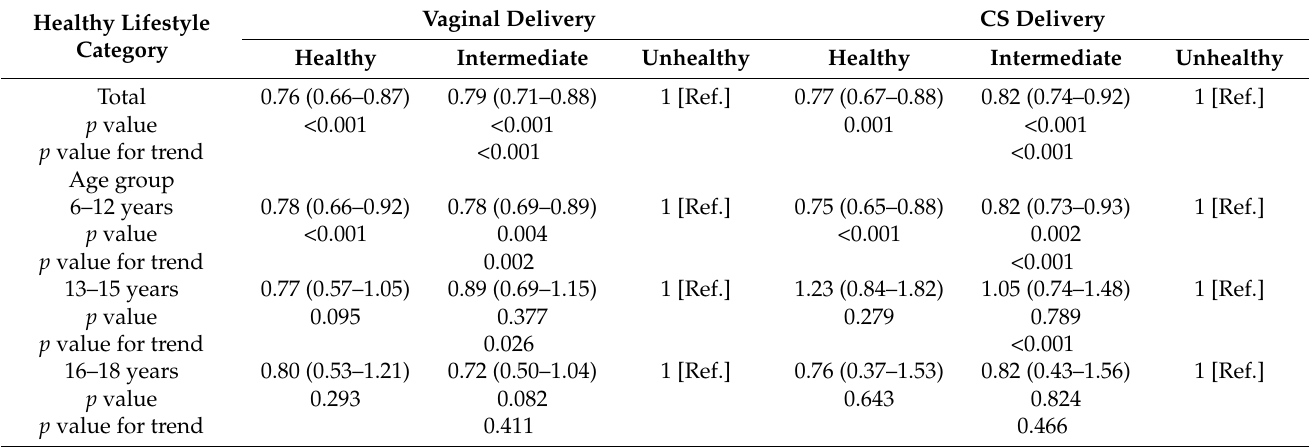
Table 4. Risk of obesity according to healthy lifestyle category within delivery mode in children and adolescents aged 6–18 years.